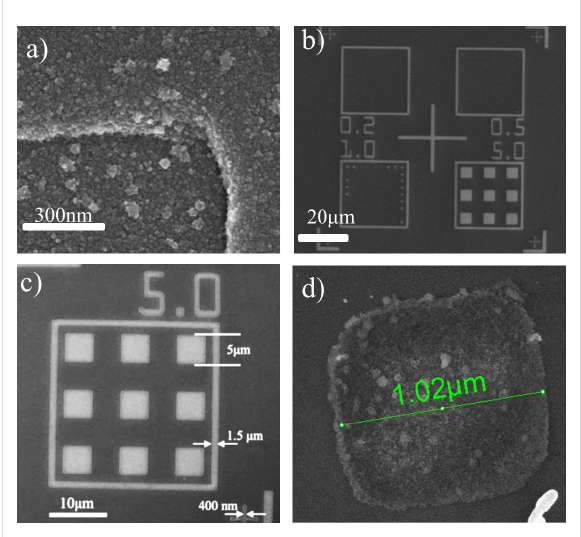
Figure 11: Scanning electron microscopy image of 3D patterns composed of Hf NPs deposited at a substrate voltage of V s = 4.5 kV: a) The high-magnification image shows the granular structure of these patterns; b,c) the areas that appear white are structures formed from the nanoparticles. Large square structures of 5 μ m size were success- fully constructed. d) Cohesive structure with 1 μ m side found at a random position on the